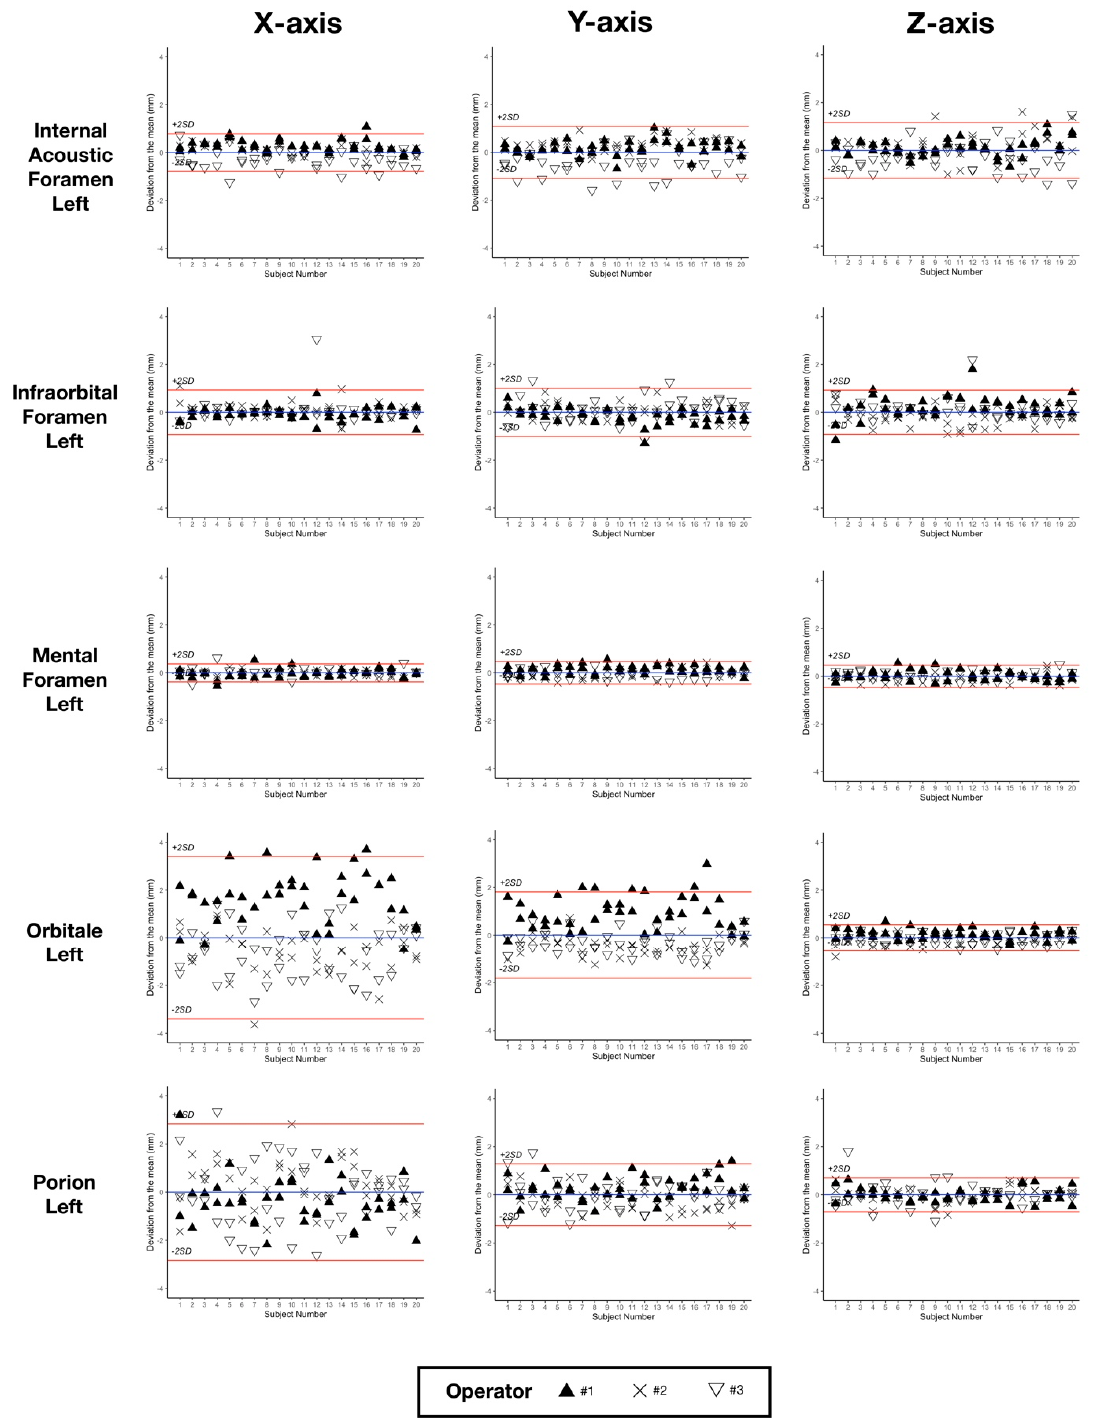
Figure 2. Bland-Altman plots for five left landmarks, showing the deviations from the mean (blue line) of the 6 repetitions for the 20 subjects. Red lines show the ± 2×SD of reproducibility. SD, standard deviation.